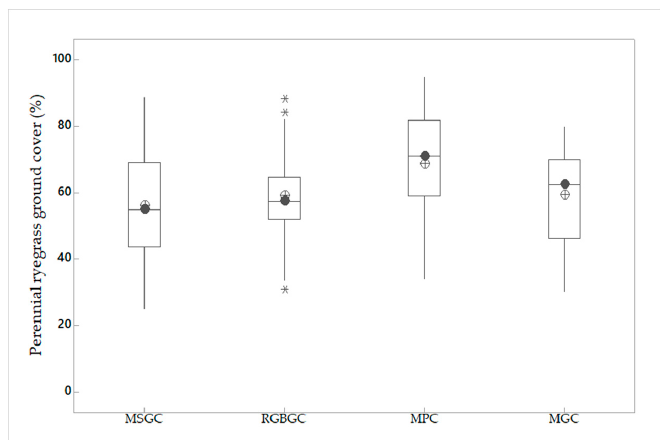
Figure 2. The pairwise comparison of estimated sensor-base plant ground cover and ground truth data. Where MPC is manual plant count, MGC is manual ground cover, MSGC is multispectral sensor-based ground cover, RGBGC is RGB sensor-based ground cover. The diagram also shows the median (the horizontal middle line between upper and lower box boundaries) and mean ( + ) observation for a particular method. Data falling outside the lower quartile (Q1) - quartile upper (Q3) range is plotted as outliers (*).